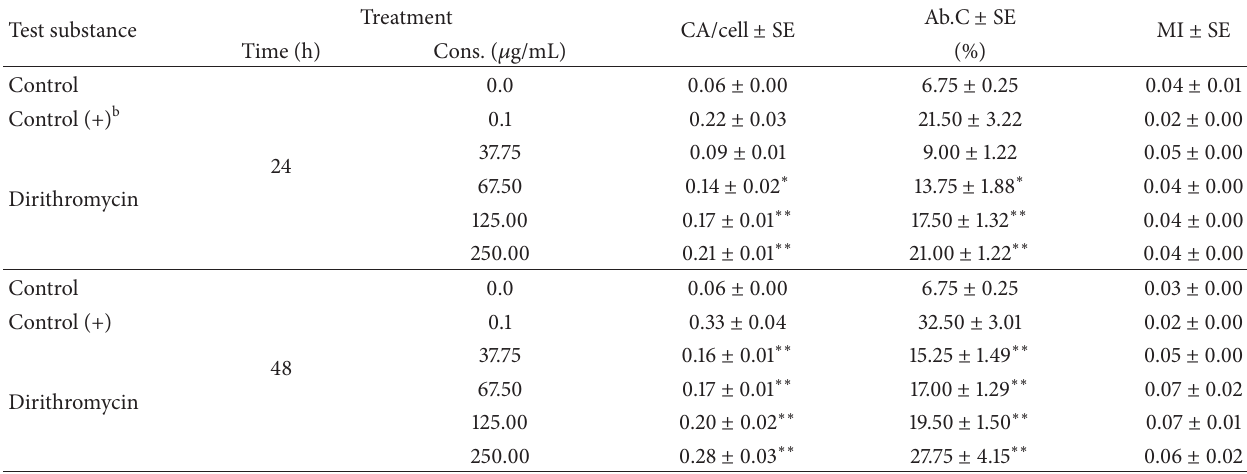
Table 2: Frequency of chromosomal abnormalities (CA/cell), abnormal cells (Ab.C), and mitotic index (MI) in cultured human lymphocytes treated with dirithromycin and